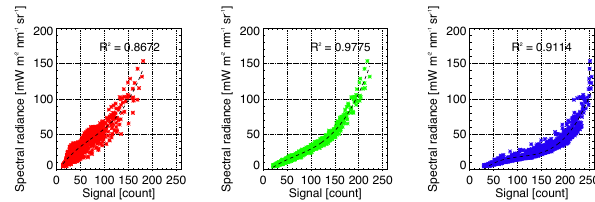
Figure 2. Non-linear relationship between the measured spectral sky radiance and the signal count for the three channels red, green and blue of the HSI system. The data are used as a training data set and were recorded on 28 October 2012 for the wavelength 500nm. The R 2 in the plots represent the correlation